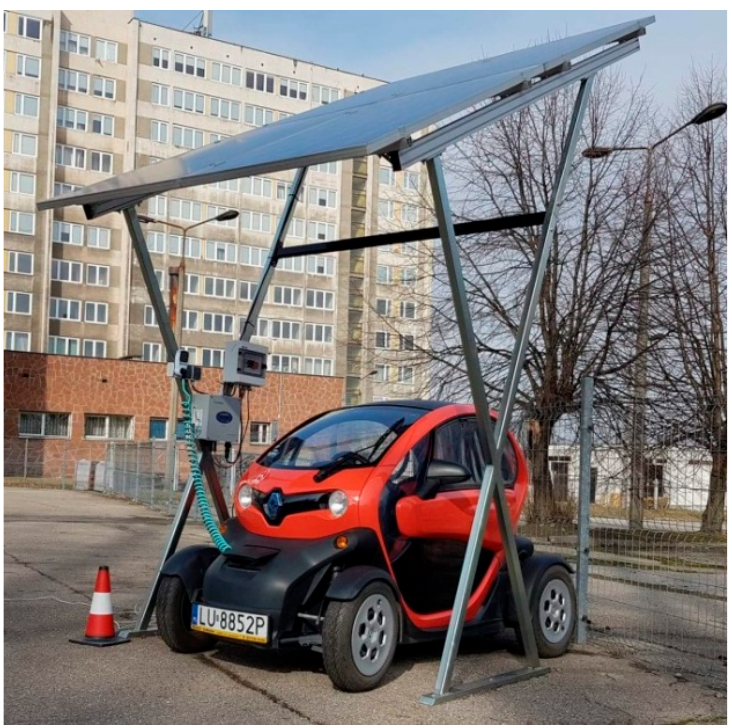
Figure 3. Carport at the WSEI during the charging of the Renault Twizy EV.